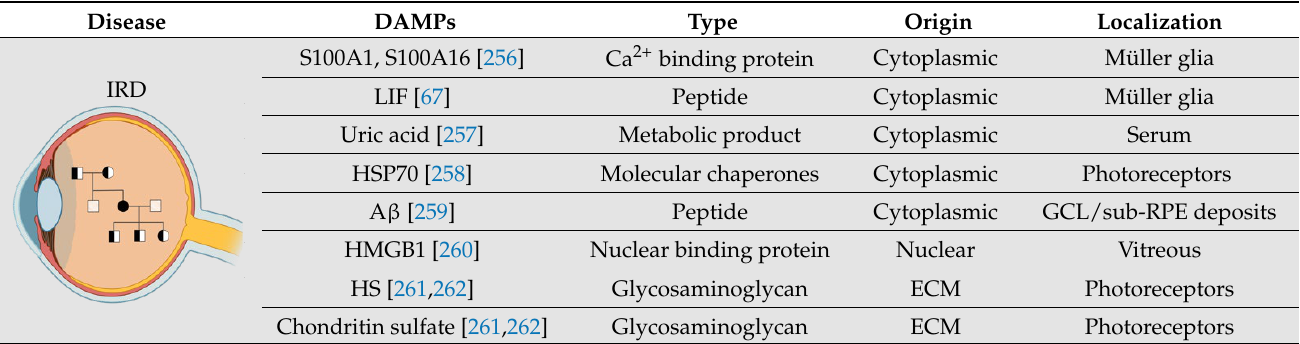
Table 9. DAMPs in inherited retinal diseases.